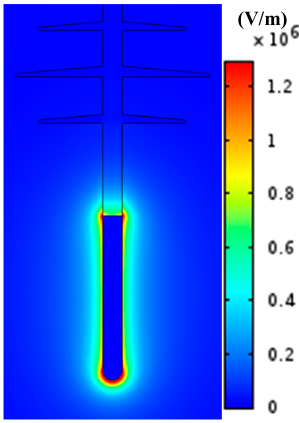
Figure 2. The high voltage end simplified model of composite insulator.